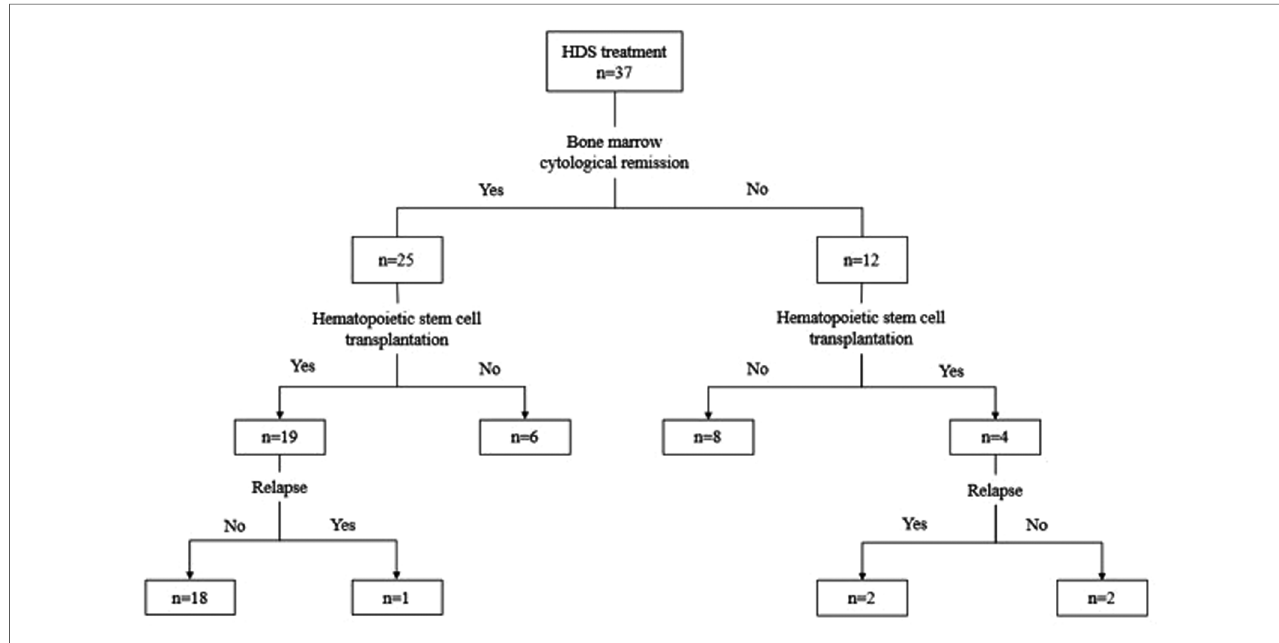
FIGURE 1 Treatment fl ows and outcomes for 37